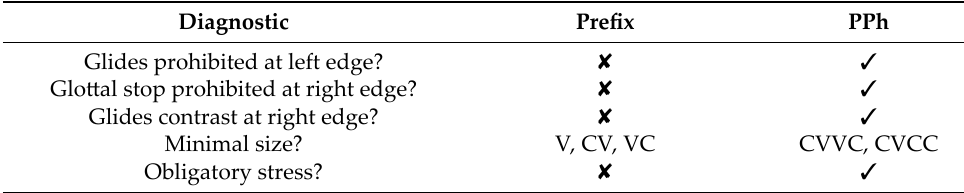
Table 7. Comparison of prefixes and PPh